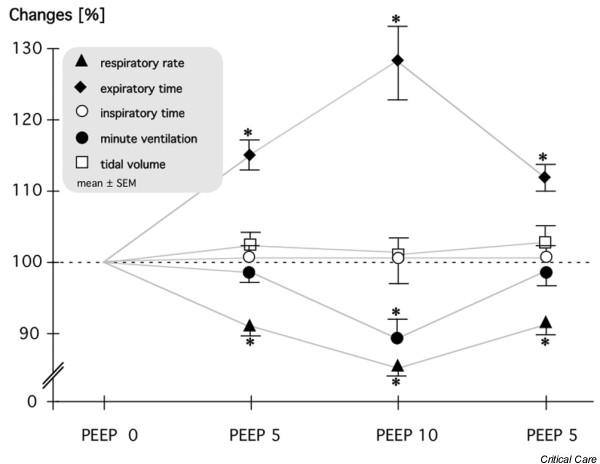
Short-term effects of PEEP on breathing pattern. The increase in PEEP is paralleled by an increase in expiratory time with a concomitant fall in both respiratory rate and minute ventilation. The decrease in PEEP has an opposite effect. Tidal volume and inspiratory time were not significantly affected by changes in PEEP in either direction. Results are outlined as averaged percentage changes from zero PEEP and are expressed as mean ± 1 standard error of the mean (SEM). *P < 0.025, versus zero PEEP. PEEP, positive end-expiratory pressure.